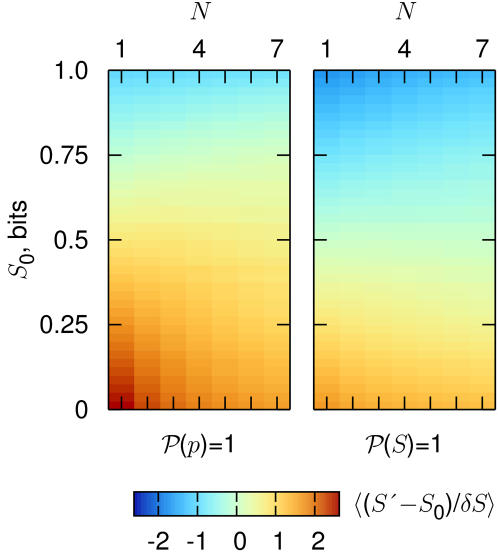
Systematic errors in entropy estimation.We consider a coin with unknown probability p of coming up heads; from N coin flips we try to estimate the entropy S = −plog2
p−(1−p)log2 (1−p); see Methods for details of the calculations. At left, we make Bayesian estimates starting from the prior hypothesis that all values of p are equally likely, P(p) = 1. We show how the best estimate S' differs from the true value S
0 when this deviation is measured in units of the estimated error bar δS (posterior standard deviation); the color bar indicates the value of this scaled deviation. For small numbers of samples, the best estimate is systematically in error by more than two times the size of the error bar, so we would have false confidence in a wrong answer, even at intermediate values of the entropy, which are most relevant for real data. At right, we repeat the same procedure but with a prior hypothesis that all possible value of the entropy are equally likely, P(S) = 1. Systematic errors still appear, but they are more nearly compatible with the error bars, even at small N, and especially in the range of entropies, which is relevant to our experiments. Notice that here the distinction between the estimators extends to N∼K = 1; similarly, we expect the uniformization of P(S) to be advantageous when N<K even if K>>1.